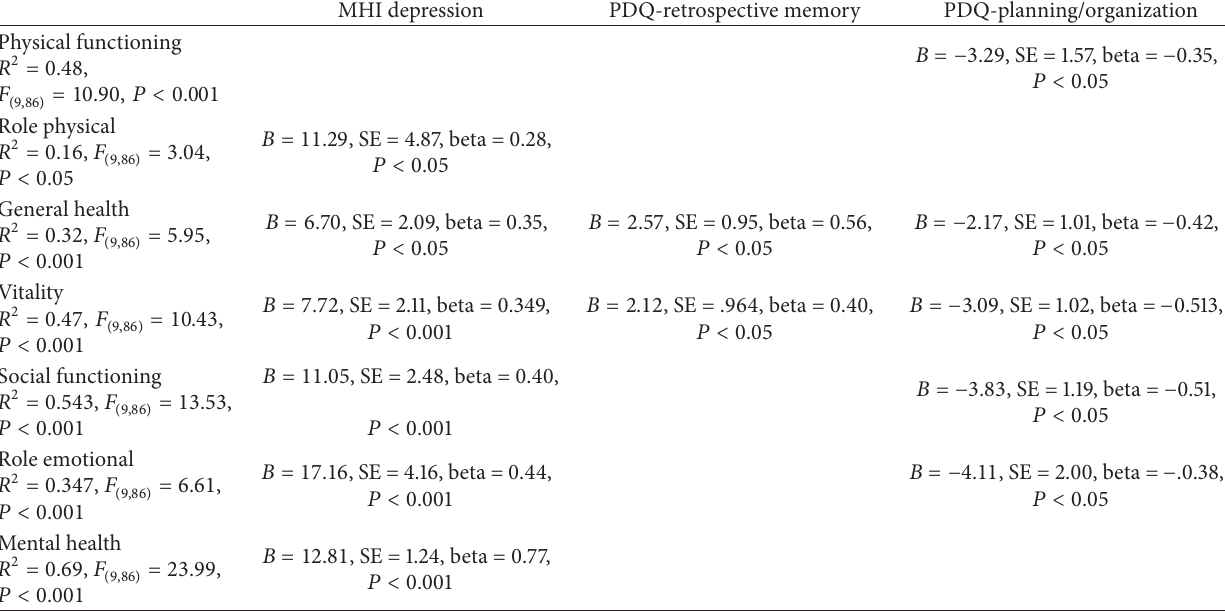
Table 2: Simultaneous multiple regression analysis summary for age, education level, EDSS, depression, attention/concentration, retrospective memory, prospective memory, planning/organization, and predicting SF-36 QoL scales. Only significant factors appear in